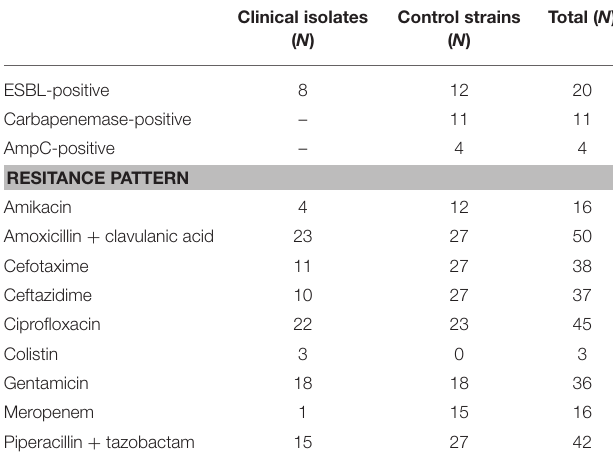
TABLE 2 | Gram negative bacilli recovered from positive blood cultures and resistance pattern according to standard reference microdilution protocol and EUCAST guidelines interpretation.